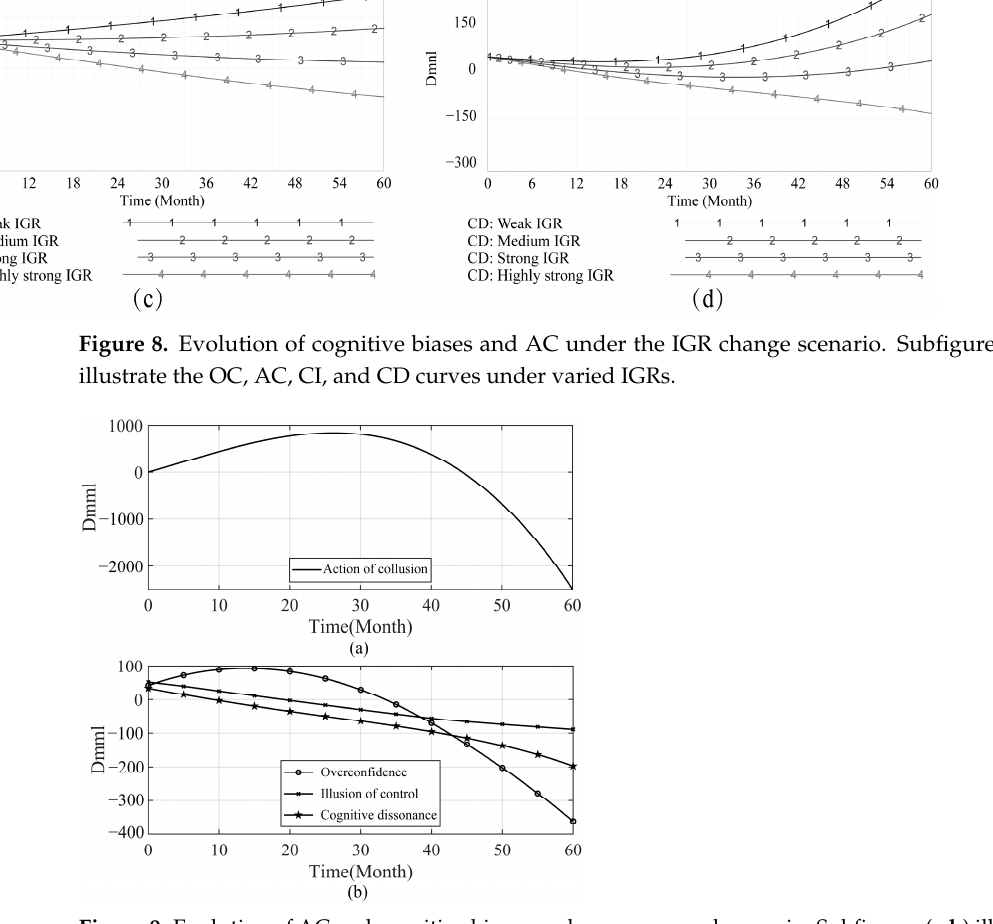
Figure 9. Evolution of AC and cognitive biases under a compound scenario. Subfigures ( a , b ) illustrate the AC, CD, OC, and CI curves under same compound scenario.